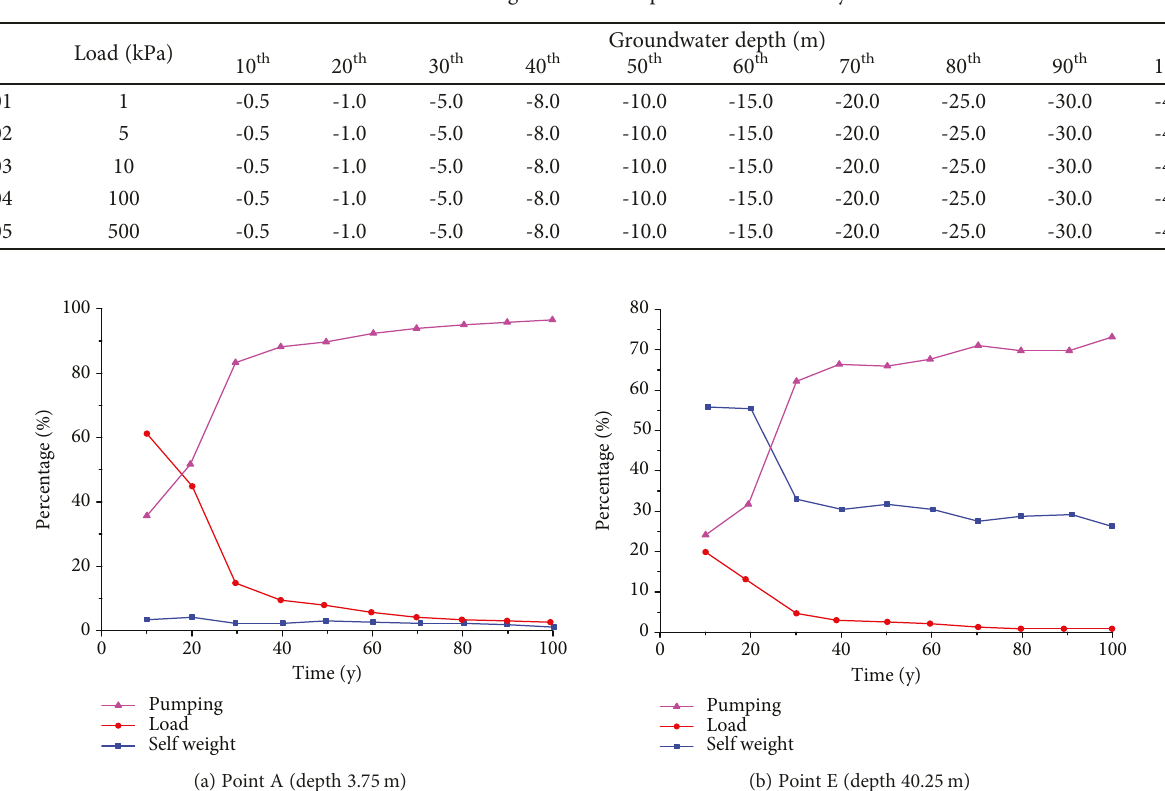
Figure 16: Percentage of partial settlement and total settlement with changing phreatic water level. Table 7: Variation of groundwater depth and load intensity.